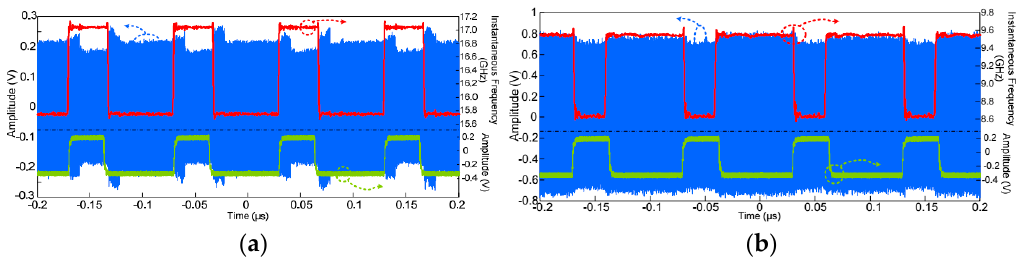
Figure 4. Measured hopping code sequence (green), waveform of the generated frequency-hopping microwave signal (blue), and the calculated instantaneous frequency of the frequency-hopping signal (red). ( a ) Frequency-hopping between 17.1 GHz and 15.75 GHz; ( b ) Frequency-hopping between 9.58 GHz and 8.65 GHz (with the courtesy of Dr J. Yao).